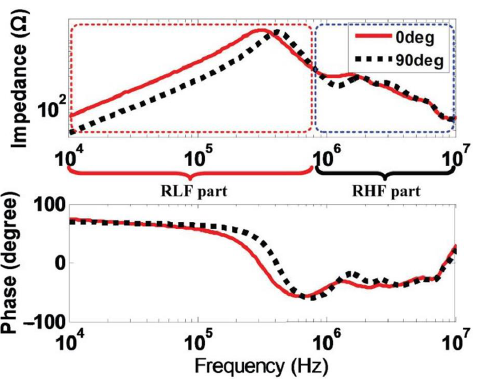
Figure 7. Differential-mode Impedance